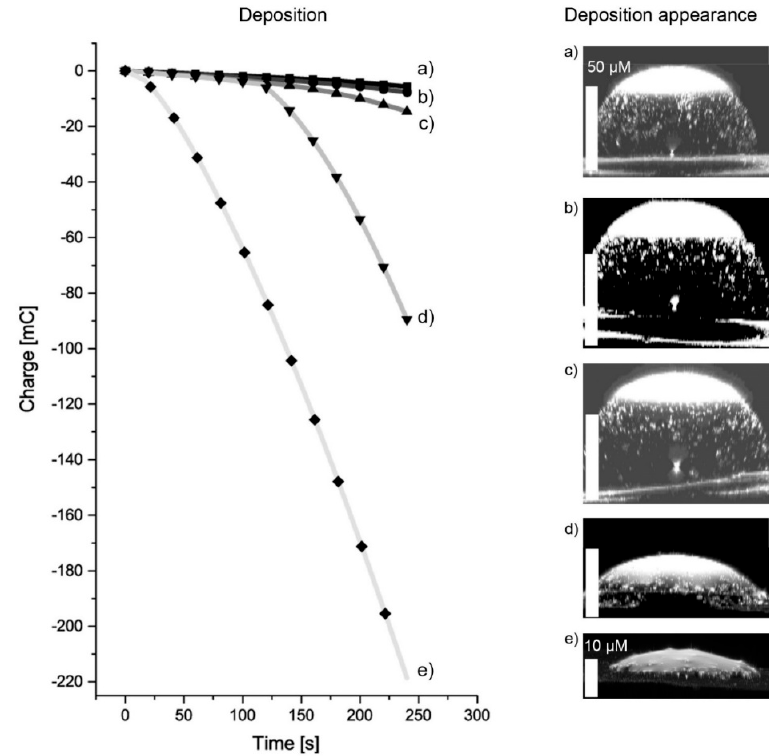
Figure 9. Mercury-deposition charge and resulting deposition appearance for five representative GAMEs. All gold electrodes were 100 µm in diameter, polished and plated with mercury as described in the method section. The electrodes ( a – e ) have the electrode identifiers JMSA_EL_AuHg_17, JMSA_EL_AuHg_20, JMSA_EL_AuHg_19, JMSA_EL_AuHg_18, and JMSA_EL_AuHg_21, respectively. The white bar represents 50 µm unless otherwise specified.